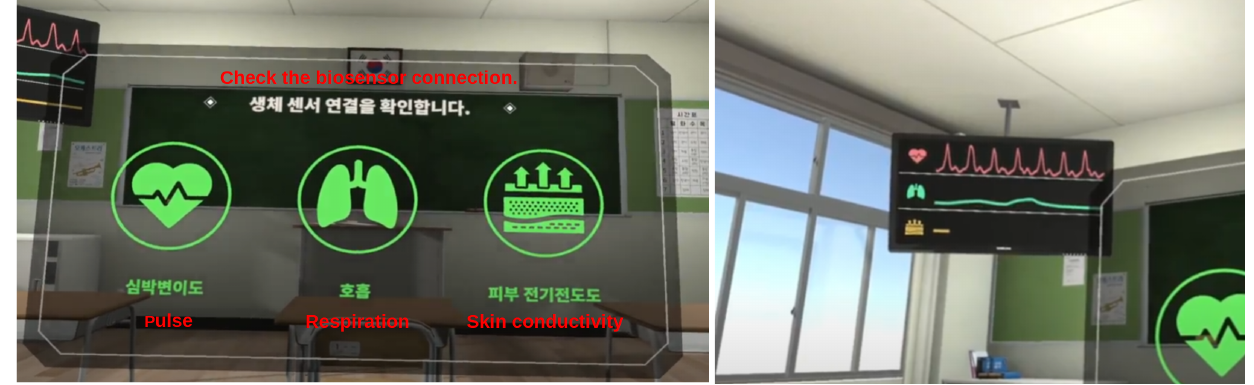
Figure 2. Connectivity indicators for pulse, respiration, and GSR (skin conductivity) sensors with translated annotations ( left ). Sensor data visualization on a virtual television screen ( right ).